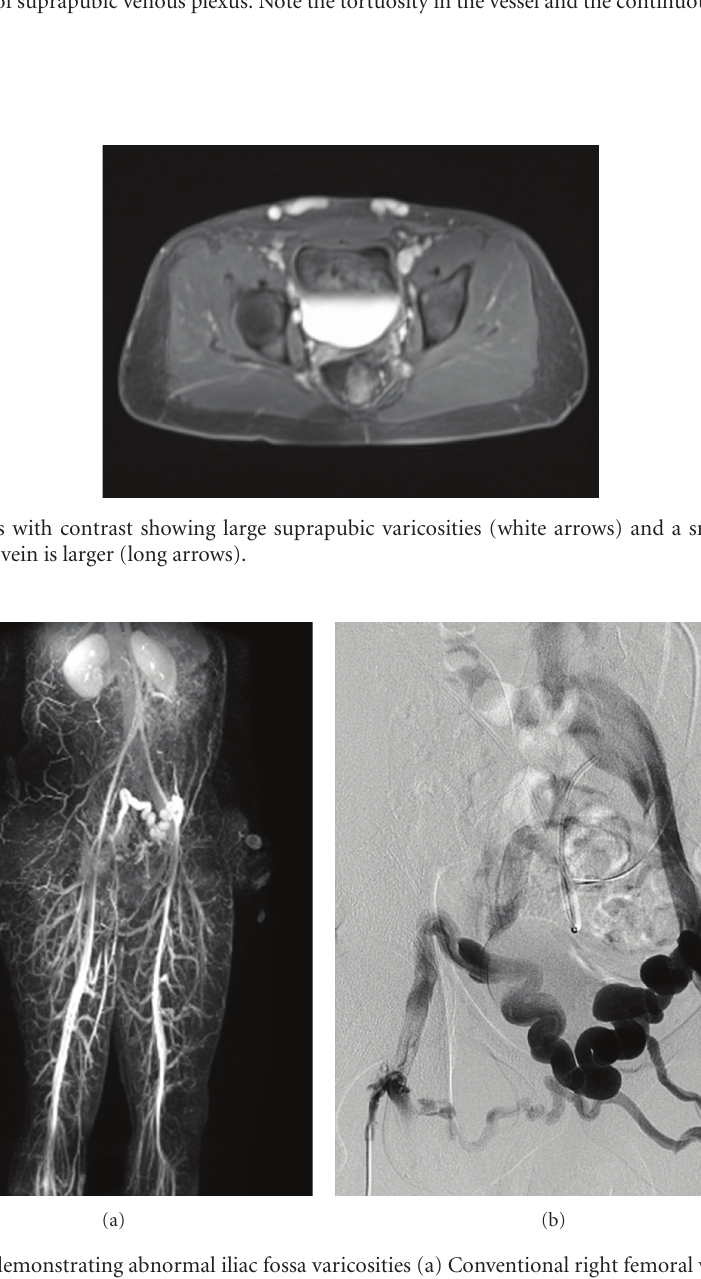
Figure 3: MRI with contrast demonstrating abnormal iliac fossa varicosities (a) Conventional right femoral venogram demonstrating large right to left cross pelvic collaterals to the left femoral system